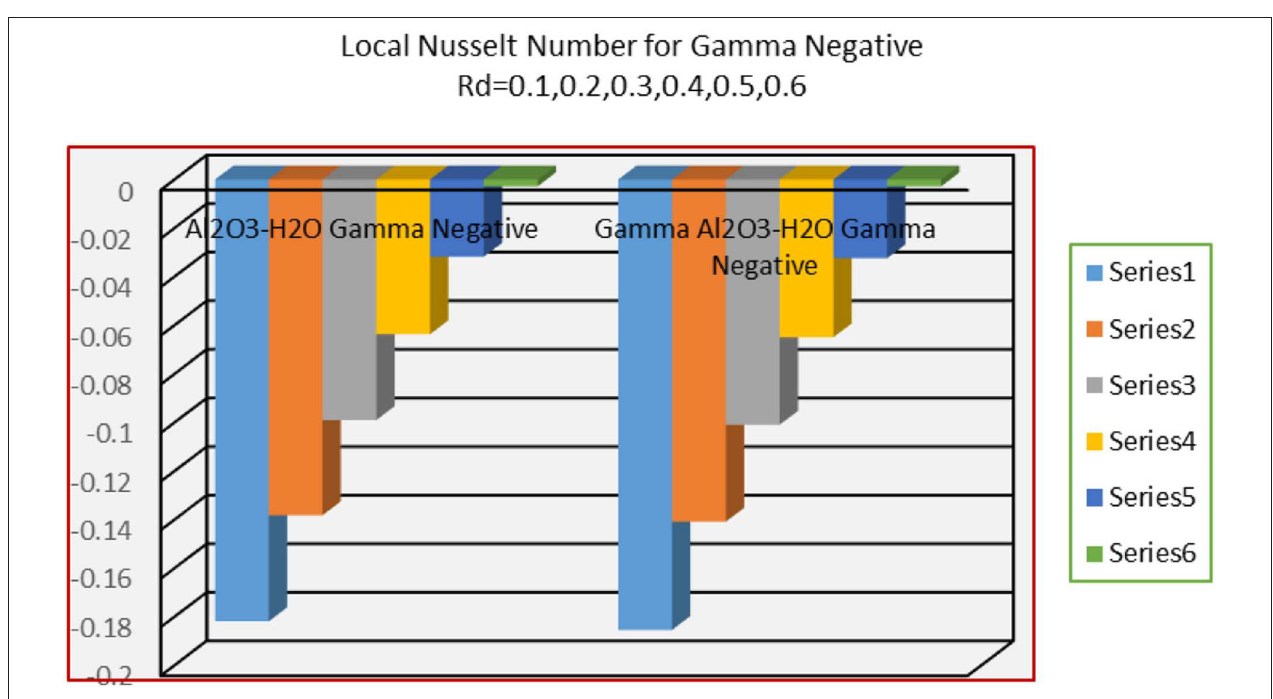
FIGURE 14 | The effects of Rd on local Nusselt number ( γ <